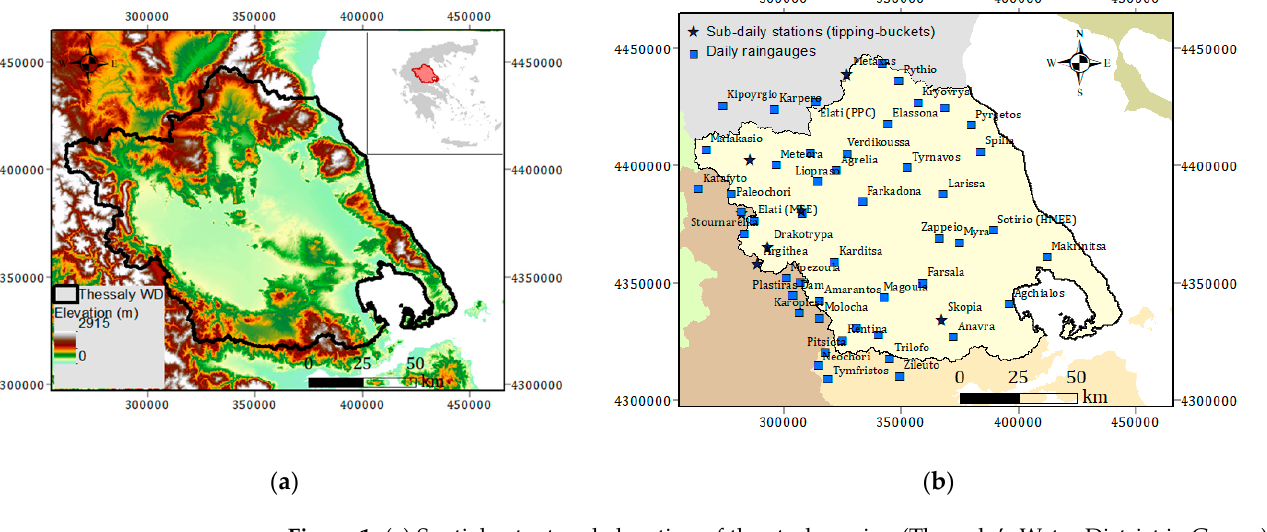
Figure 1. ( a ) Spatial extent and elevation of the study region (Thessaly’s Water District in Greece). ( b ) Geographic location of the 55 rainfall records, from daily raingauges and sub-daily tipping-buckets, with data at the 24 h scale (used in the BSS/BSSE models and the EV2 distribution modeling).